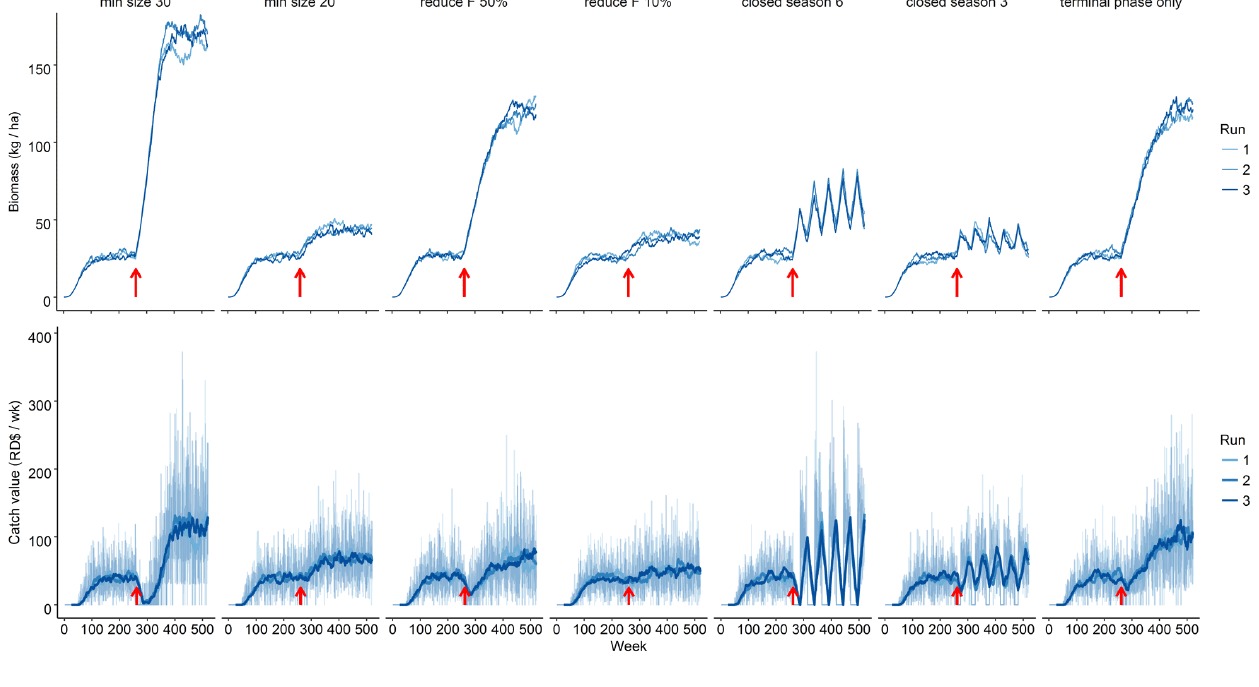
Fig. 3 . The responses of population biomass (top panel) and catch value (bottom panel) to fishery management interventions (y- axes of panels) through time. Each blue path depicts a model run. In the bottom panel, faint lines show weekly catch values, and heavy blue lines show the 6-month moving average of catch value. Populations in all runs started with 30 individuals; red arrows indicate when rules were first applied. Minimum sizes are in centimeters, and closed seasons are in months.